Question: What form of chart is displayed?
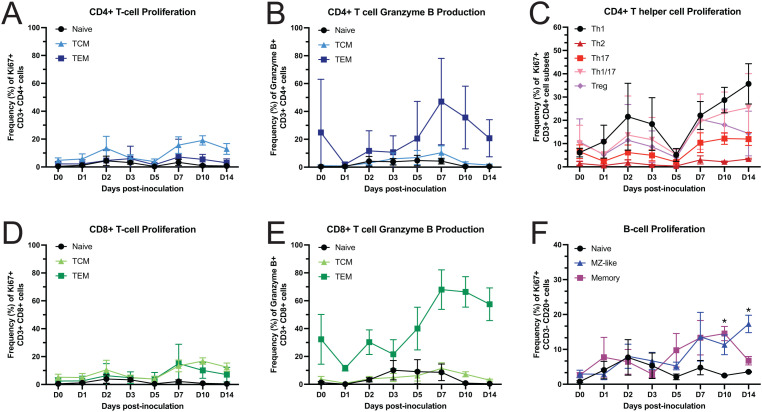
Answer: bar